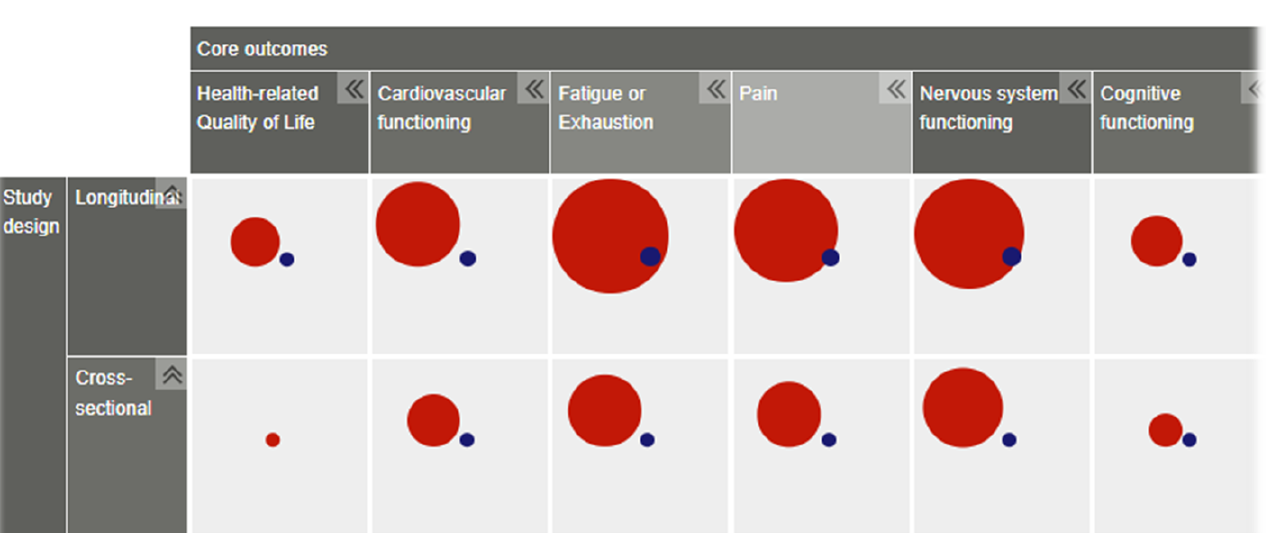
Figure 2. Distribution of studies per country (darker blue indicates a higher density of studies). Footnotes: Darker blue indicates a higher density of studies per country. The top 10 countries with the highest number of studies included the United States (87), Italy (75), the United Kingdom (50), China (47), Spain (42), Germany (24), France (18), India (16), Turkey (13), and Brazil (12).